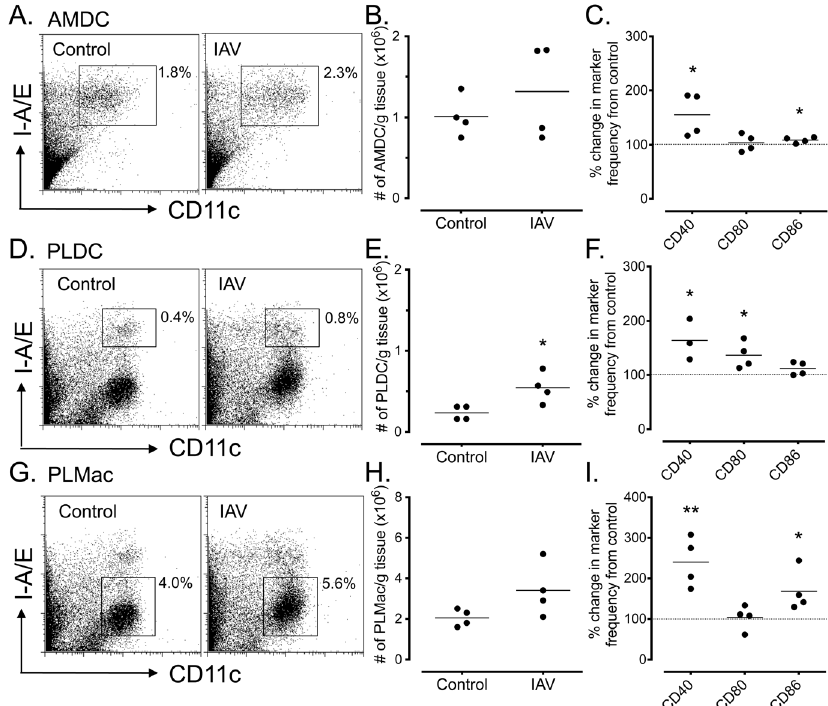
Figure 7. Long-term changes in total cell numbers of, and co-stimulatory molecule expression by, of respiratory APC populations following IAV infection in early life. Juvenile (28 day old) BALB/c mice were infected i.n. with a weight-adjusted dose of IAV as described in Materials and Methods, then respiratory tissues harvested 35 days later as 8 week-old adults. (A) Representative FACS profiles showing gating for AMDC in tracheal tissue of control (left) and IAV infected mice (right). (B and C) Total AMDC numbers (B) and percentage changes in co-stimulatory marker expression (C) , expressed a percentage change from control mice. (D) Representative FACS profiles showing gating for PLDC in parenchymal lung tissue of control (left) and IAV infected mice (right). (E and F) Total PLDC numbers (E) and percentage changes in co-stimulatory marker expression (F) , expressed a percentage change from control mice. (G) Representative FACS profiles showing gating for PLMac in parenchymal lung tissue of control (left) and IAV infected mice (right). (H and I) Total PLMac numbers (H) and percentage changes in co-stimulatory marker expression (I) , expressed a percentage change from control mice. Data are shown for 4 independent infection experiments, using pools of tissue from 4 to 5 mice for each experiment. * = p , 0.05; ** = p ,